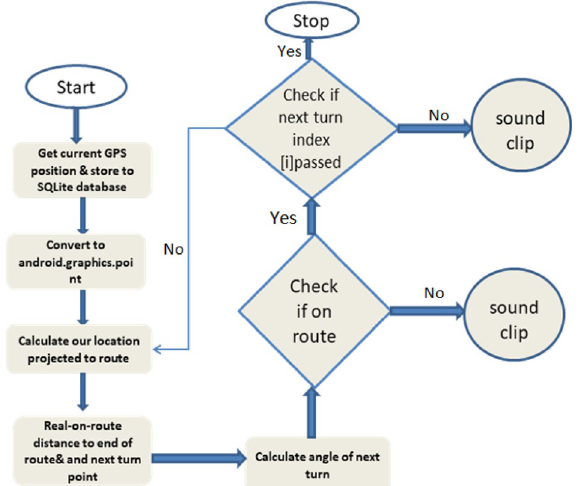
Fig. 2 A flowchart diagram for the “mGuide” application, used in this work, showing the flow of